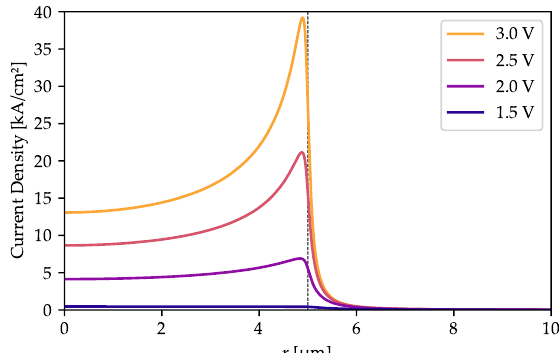
Figure 2. Current density distribution in the active region for several contact-to-contact voltages in a structure without an oxide island. There is some current-crowding at the outer oxidation edges, but only at high voltages. The dashed vertical line indicates the outer oxide aperture radius.